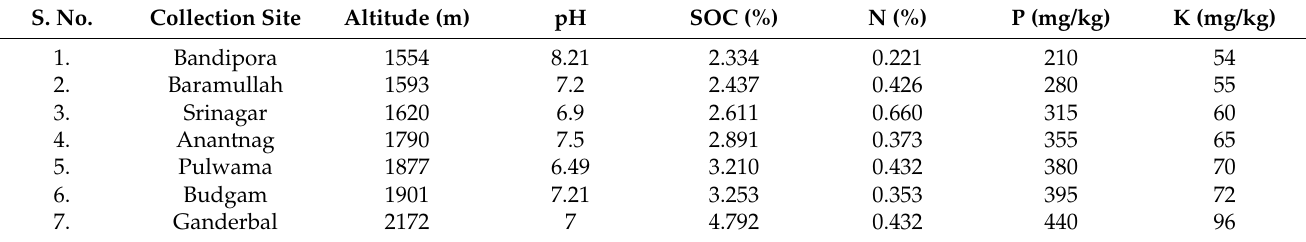
Table 3. Composition of soil at different altitudes in the Kashmir region.